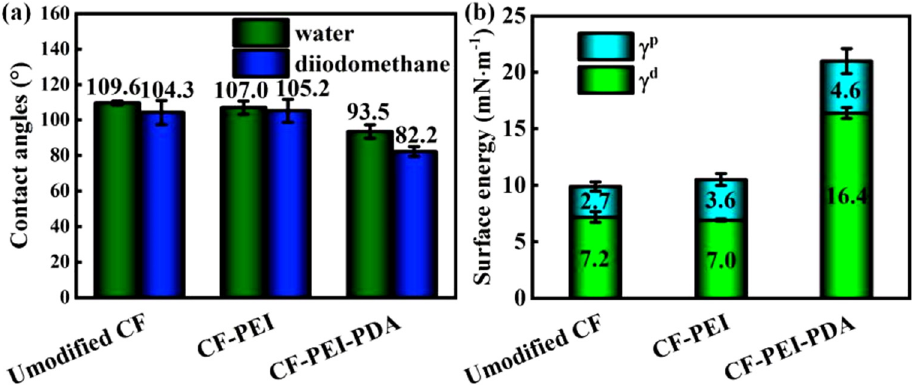
Figure 5. ( a ) Contact angle and ( b ) surface energy of different CFs.